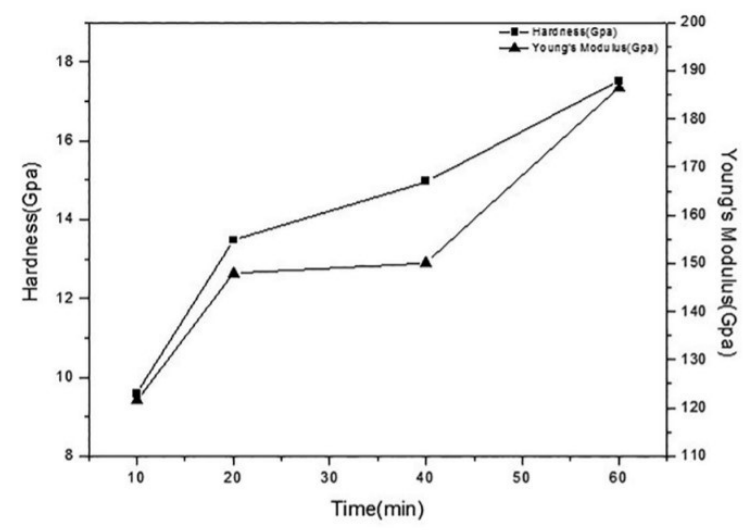
Figure 4. Hardness and Young’s modulus of the thin films with varying deposition time under 100 W plasma power [47] (Creative Commons Attribution 4.0 International License).